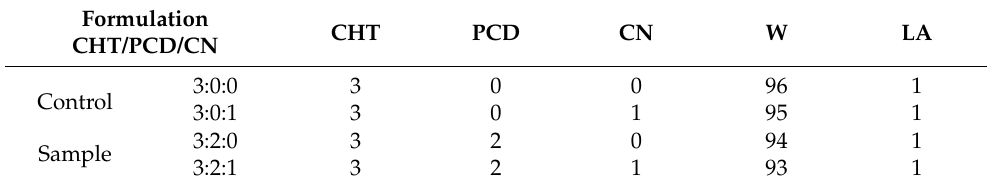
Table 5. Concentration (%w/w) of CHT, PCD, W, and LA for the preparation of the CHT/PCD/ CN hydrogel.